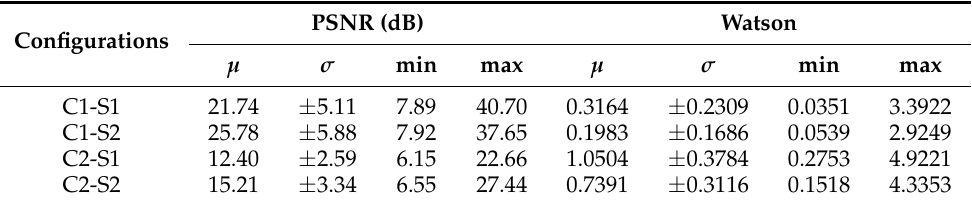
Table 5. Perceptual distortion performance for framework configuration using [35] as the fragile reversible watermarking